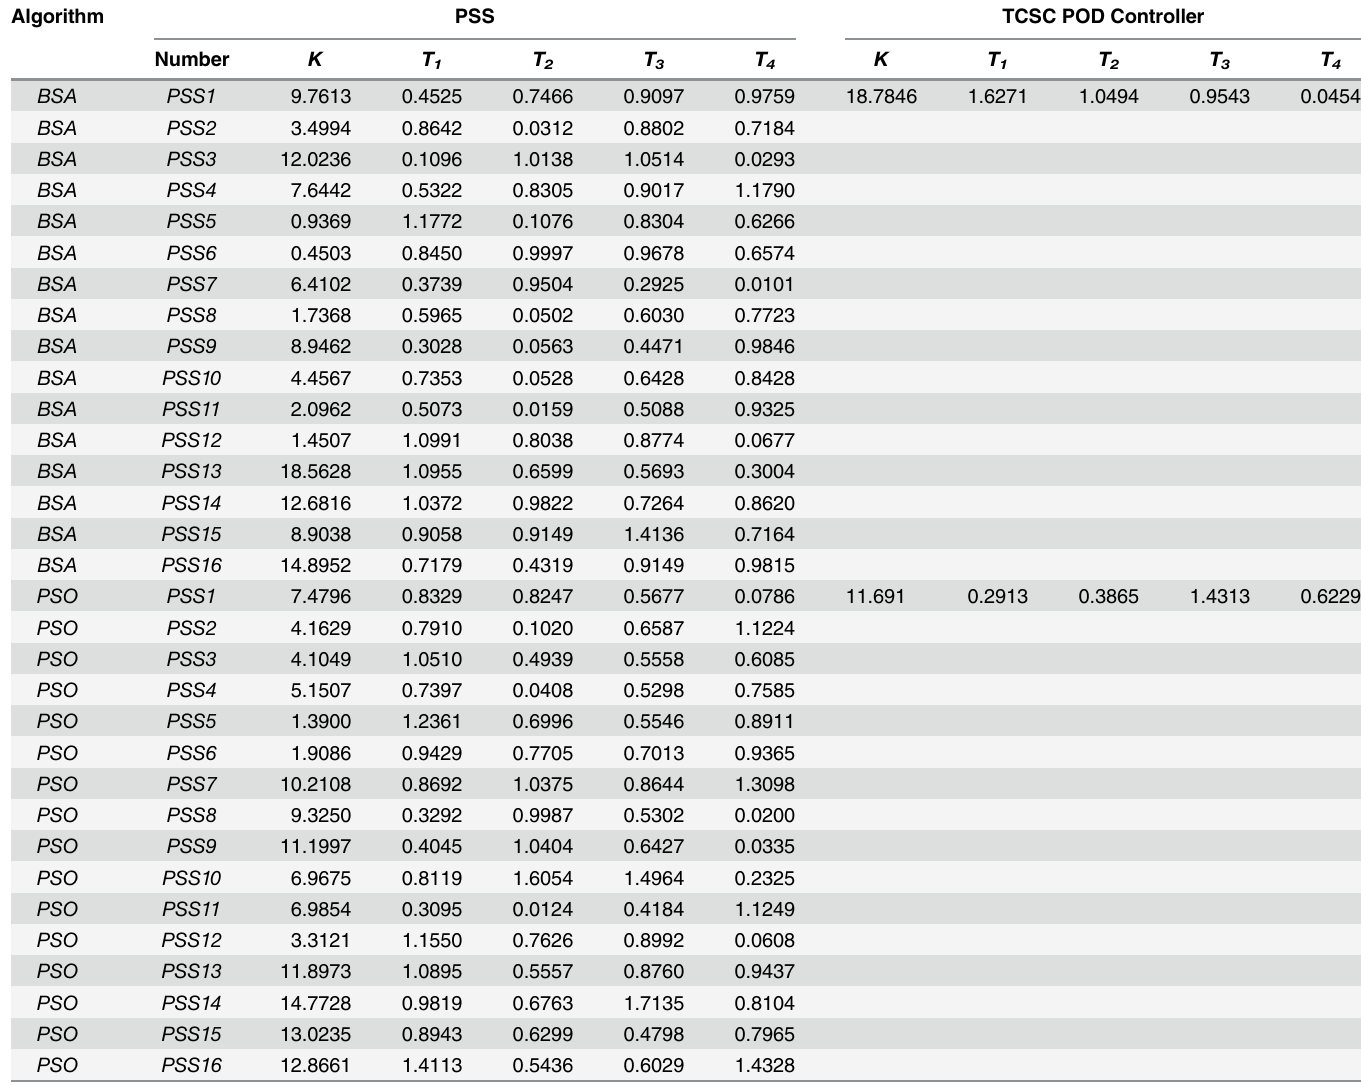
Table 3. Best optimized parameters using each optimization algorithm for the 5-area